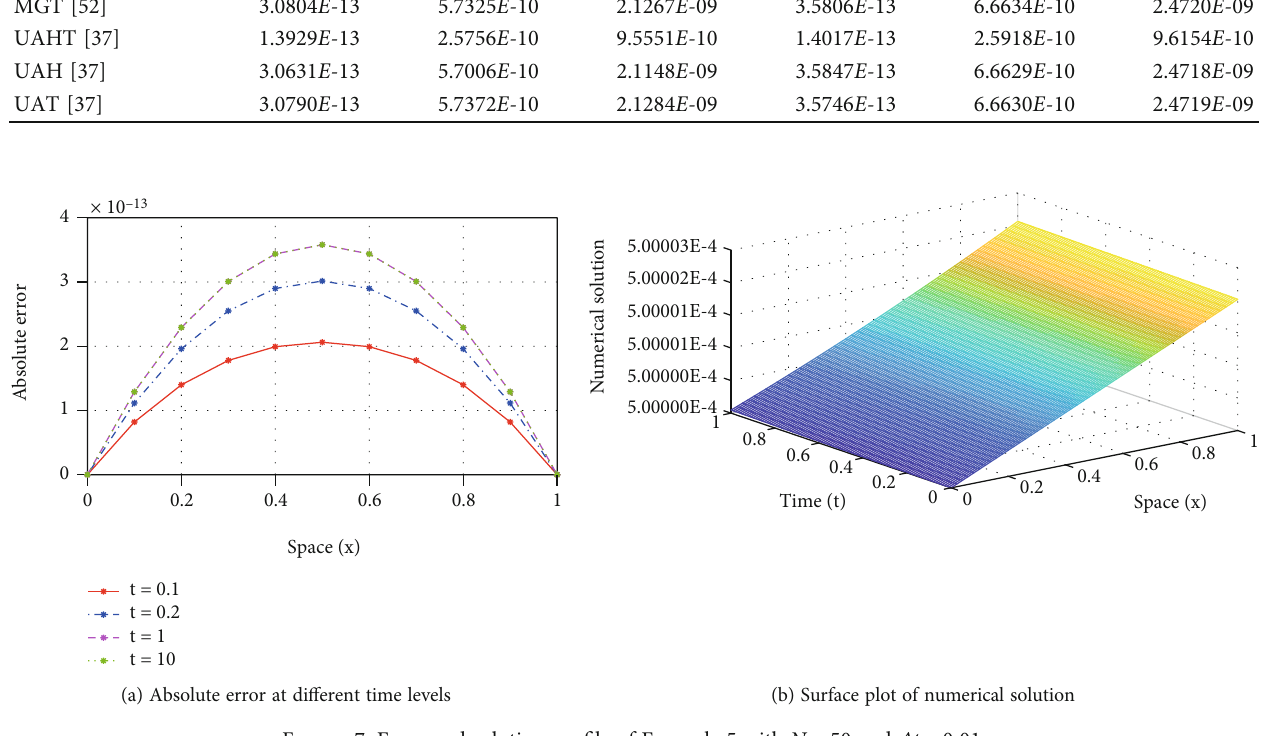
(b) Surface plot of numerical solution Figure 7: Error and solution pro fi le of Example 5 with N = 50 and Δ t = 0 : 01 .